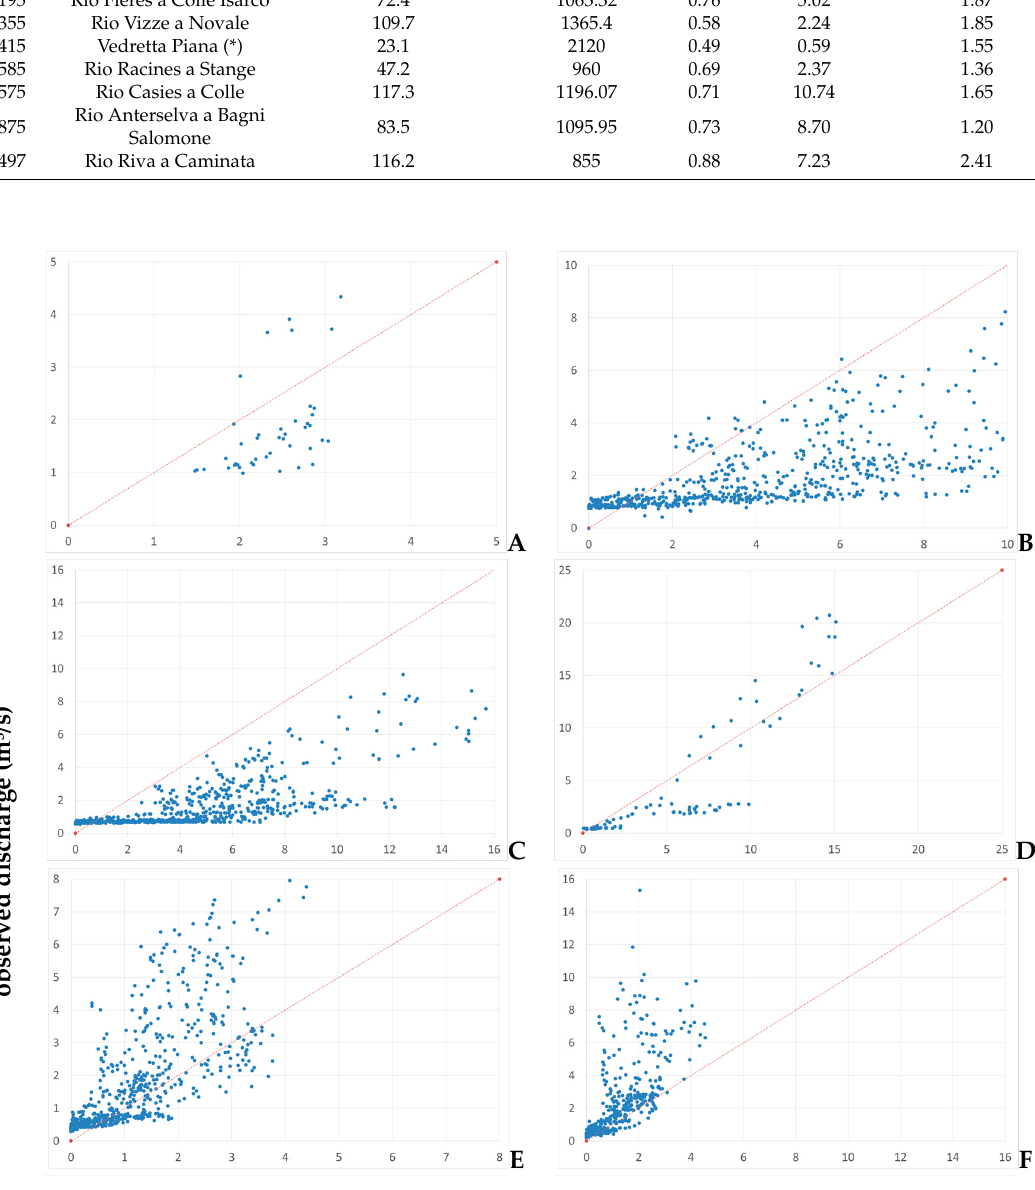
Figure 3. Comparison of observed discharges and snowmelt. ( A ) 3415: Vedretta Piana; ( B ) 4575: Rio Casies a Colle; ( C ) 4875: Rio Anterselva a Bagni Salomone; ( D ) 5497: Rio Riva a Caminata; ( E ) 2075: Rio Plan-Eschbaum; ( F ) 3585: Rio Racines a Stange; ( G ) 3355: Rio Vizze a Novale; ( H ) 3195: Rio Fleres a Colle Isarco. 1:1 lines represented in red with rounded tips. 4. Conclusions We have proposed and tested a novel method to derive the snowmelt coefficient of a DDM-based model directly from snow cover and weather data. The method is simple, and yields spatially distributed SWE and snowmelt estimates reasonably consistent with observations. While we do not account for fine-scale spatial variability, the approach may capture watershed-scale variability of melt energy and freezing levels as reflected in the interplay between snow cover and weather forcing, the key element needed in large-scale snow models [81].